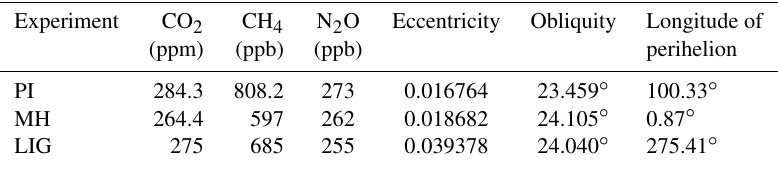
Table 2. PMIP4 boundary conditions for pre-industrial, mid-Holocene, and Last Interglacial